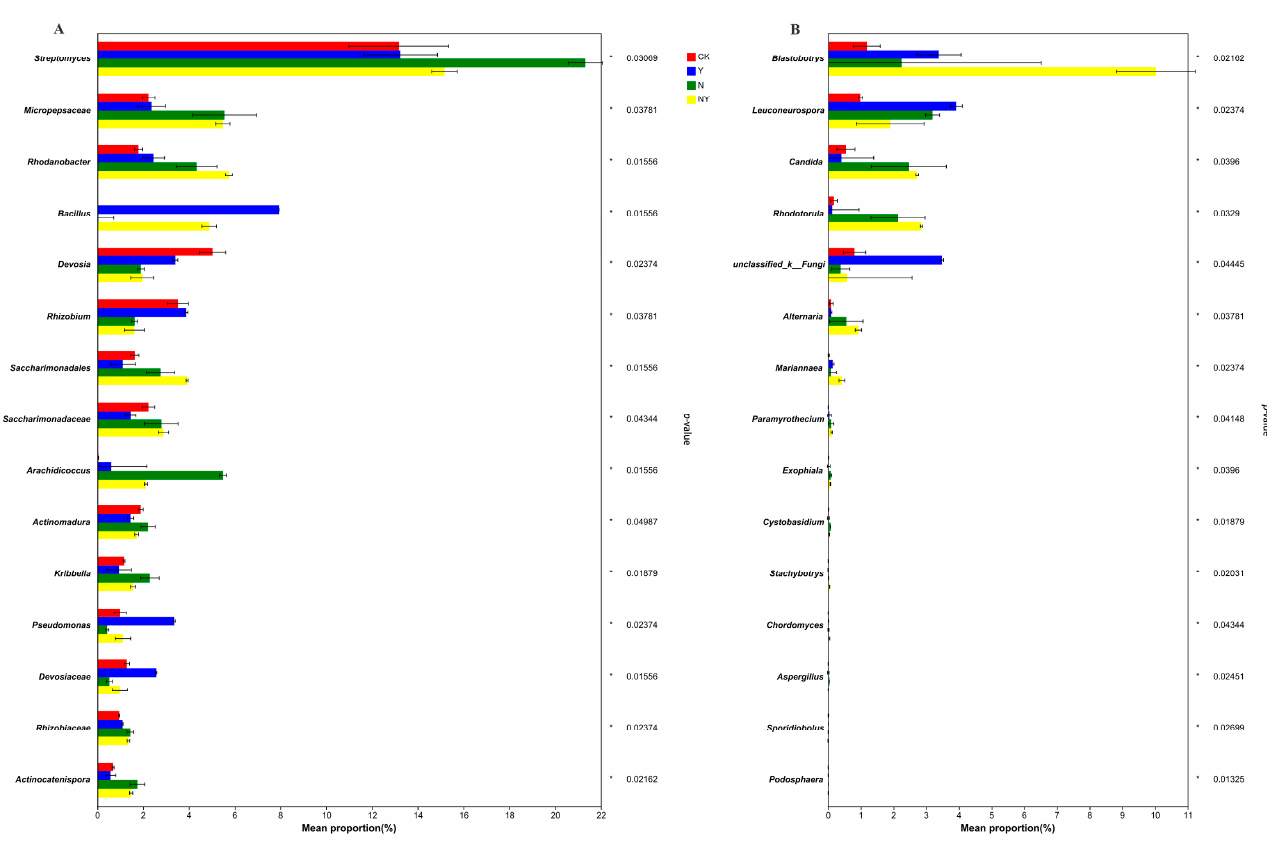
Figure 6. The top 15 classified bacterial ( A ) and fungal genera ( B ) in samples collected from different treatments. Different treatments: CK (control), seedlings were irrigated with normal nutrient solution; Y, control + B. subtilis K424; N, four-strength control; N + Y, four-strength control + B. subtilis K424.